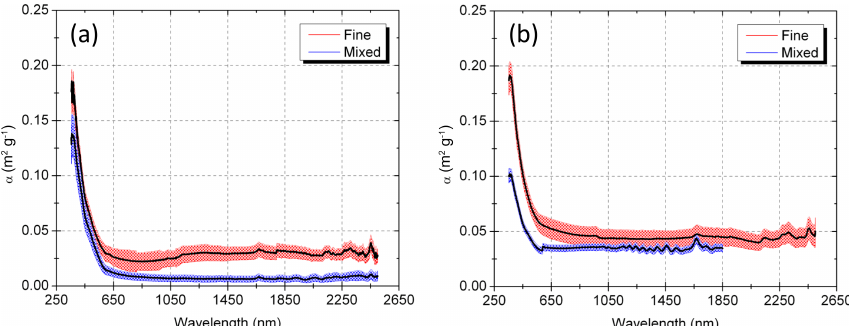
Figure 7. Spectral mass absorption efficiency ( α abs ) for fine- and mixed-mode particles of the Saharan dust collected on filters during the Fennec campaign in (a) Algeria and (b) Mauritania (group 1). Uncertainties shown as error bands in this figure were estimated by propagating the error from the power law fitting, and they represent 1 standard deviation around the black lines.